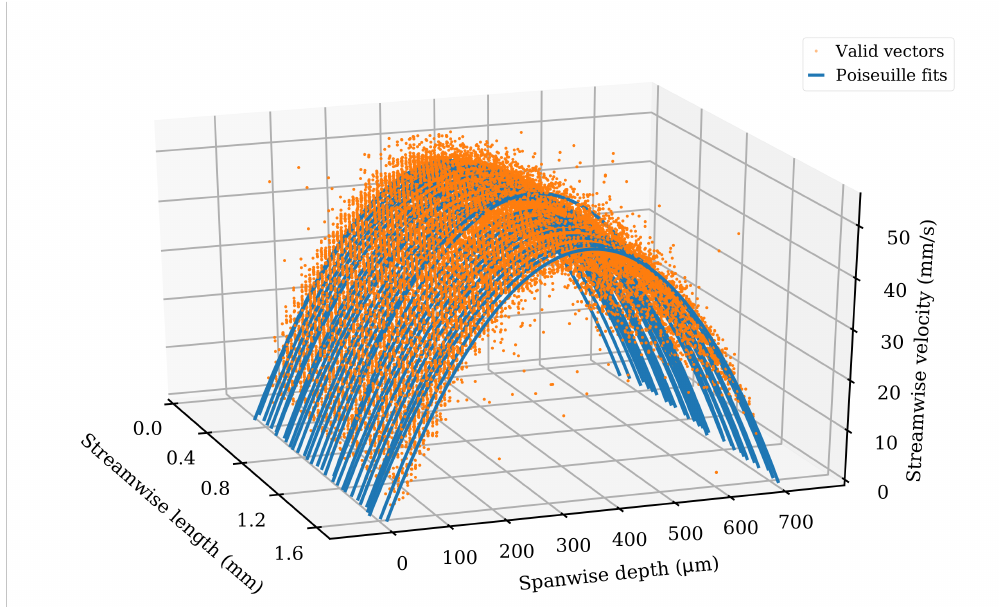
Figure 6. Spatially-resolved flow vectors and velocities for the straight channel microfluidic chip. Flow velocity is shown on the z-axis. The x-axis is divided into spatial bins of 10µm. The y-axis is continuous. Orange dots represent individual valid velocity vectors, whilst blue lines represent the parabolic Poiseuille equation fits. There are 140,000 valid vectors. Only every second streamwise bin is plotted for clarity.